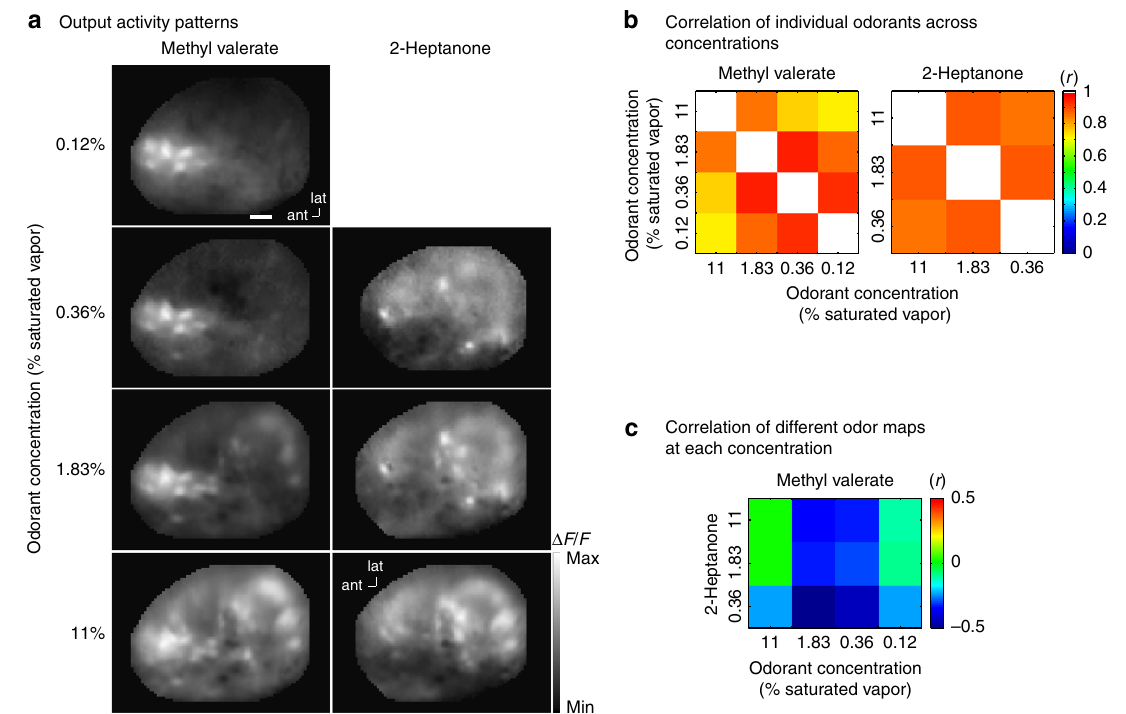
Fig. 5 Output maps are relatively concentration invariant, but odorant speci fi c. a Maps of the output in response to the two odorants methyl valerate and 2-heptanone presented at a range of concentrations. The largest signals ( Δ F / F ) from lowest to highest concentration for methyl valerate: 17%, 22%, 27%, 46%; 2-heptanone 13%, 22%, 50%. b Correlation of output maps evoked by the same odorant across a range of concentrations. c Correlation of the output maps evoked by two different odorants across a range of concentrations. This example is from a Thy1-GCaMP6f transgenic mouse in which GCaMP6f is selectively expressed in bulb output neurons 27 (Supplementary Fig. 1g – i). Similar results were obtained in two other preparations using Pcdh21-Cre transgenic mice with AAV1 GCaMP6f injections when comparing methyl valerate to isoamyl acetate, or methyl valerate to 2-hexanone. Scale bar in a 250 µ m. ant, anterior; lat,